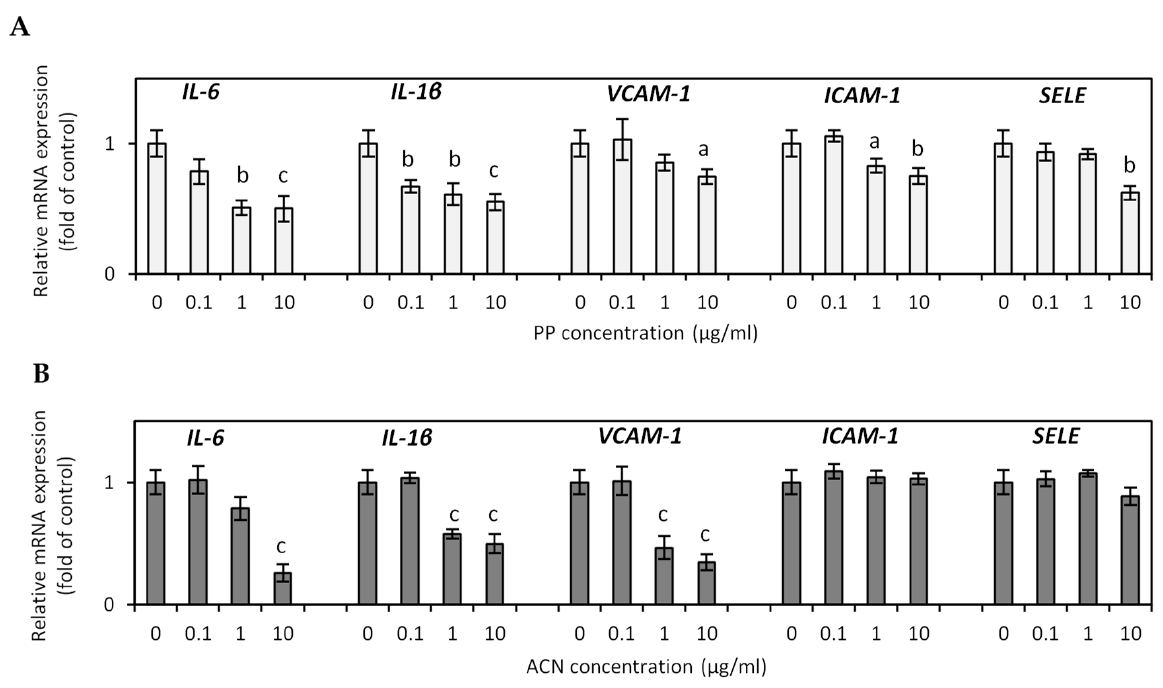
Figure 4. Effect of non-anthocyanin polyphenol (PP) fraction ( A ) and anthocyanin (ACN) fraction ( B ) on inflammatory- related gene expression in HUVECs. Data are the mean values ± SD (n = 3). a p < 0.05, b p < 0.01, c p < 0.001.